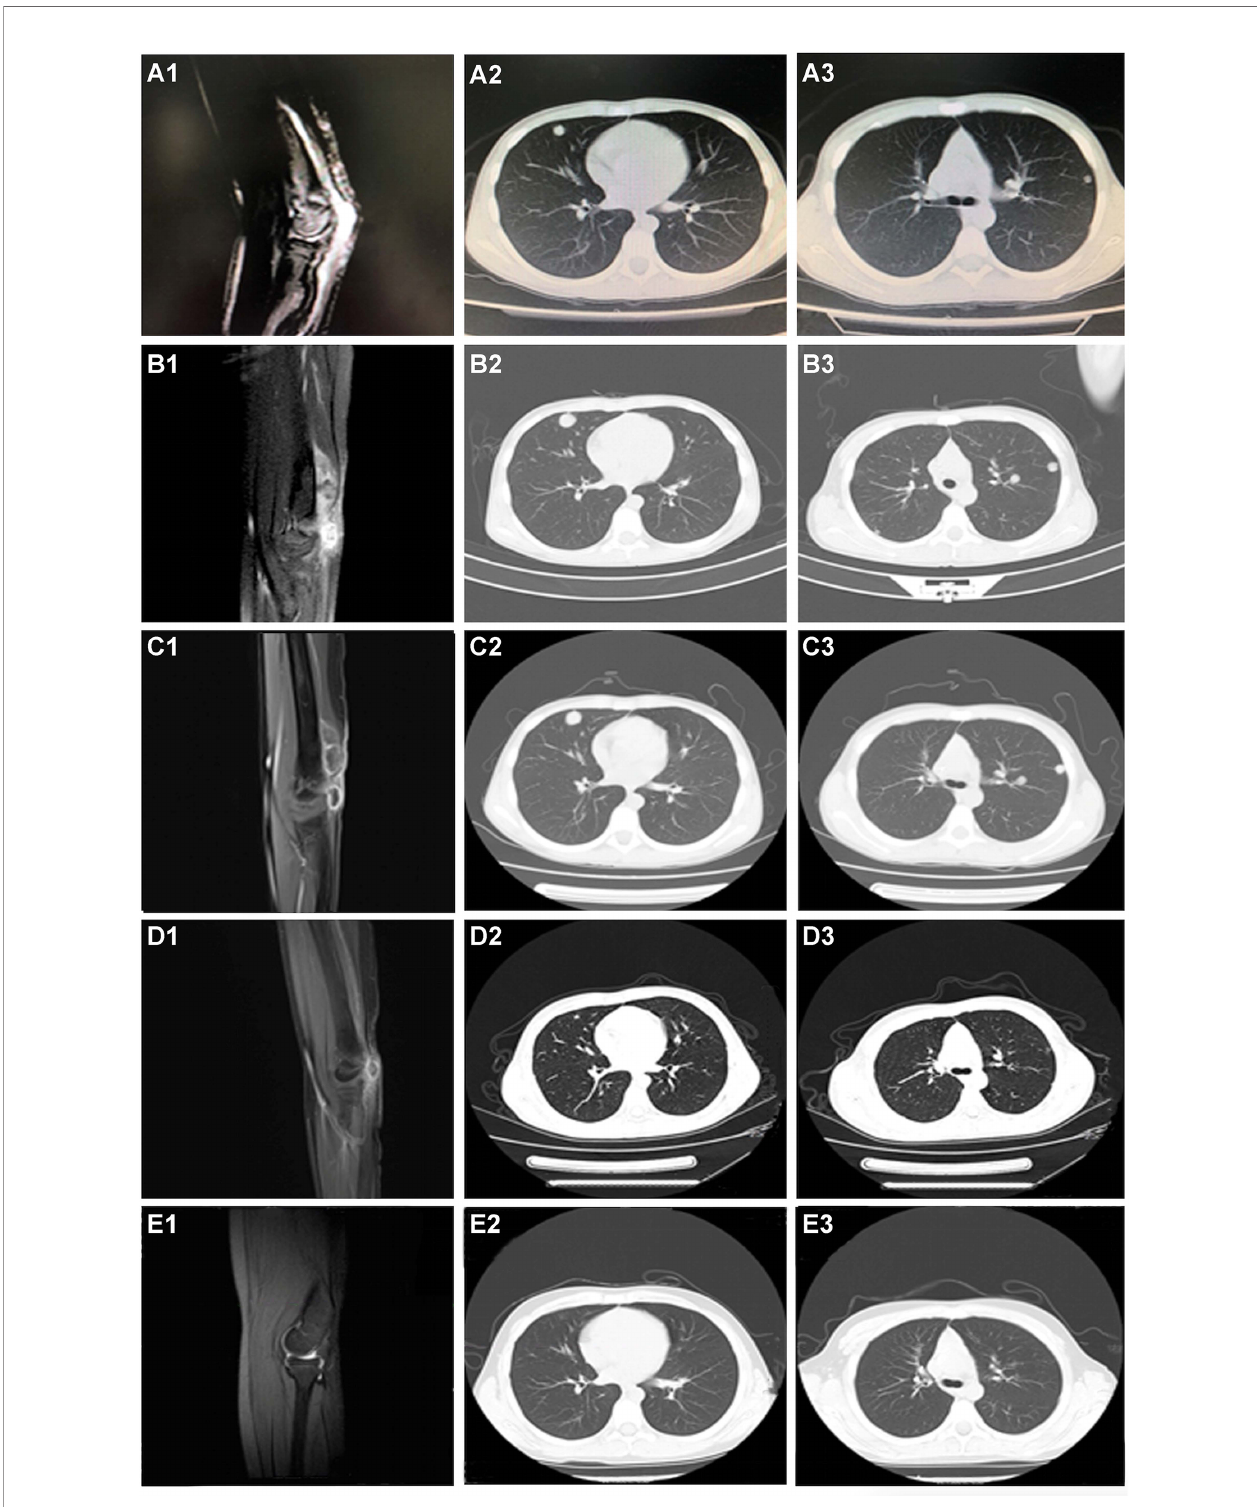
FIGURE 2 | CT scanning during the whole treatment. (A1 – A3) Before any systemic treatment. (B1 – B3) After one cycle of chemotherapy and endostar. (C1 – C3) After 1 month of pazopanib. (D1 – D3) After four cycles of nivolumab. (E1 – E3) The last followed up scanning. The fi rst column was the limb viewport; the middle and last column was the lung